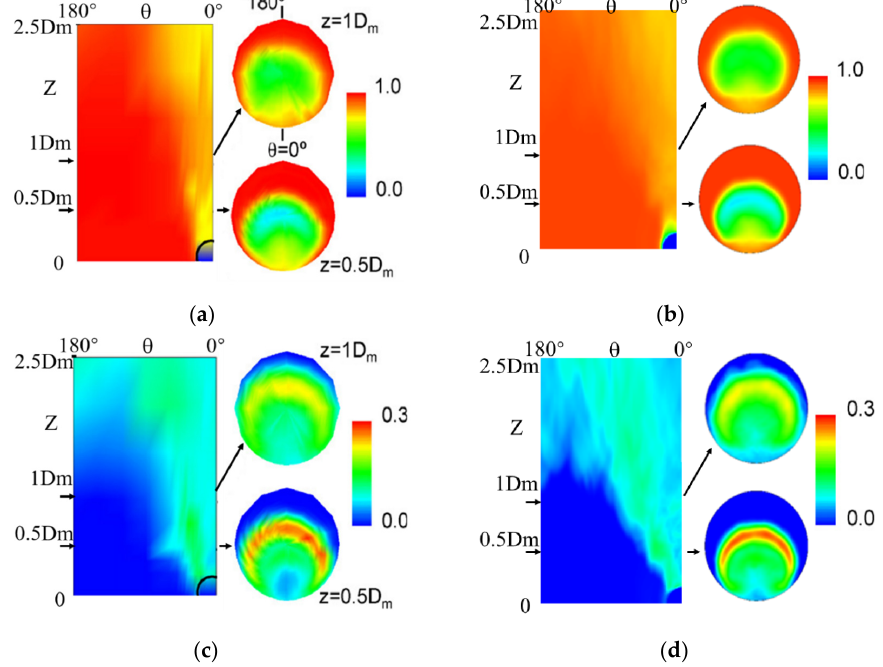
Figure 7. Temperature distribution downstream of D-ref case using LES and ELES: ( a ) Temperature T * distribution using LES; ( b ) Temperature T * distribution using ELES; ( c ) Temperature T sd* distribution using LES; ( d ) Temperature T sd* distribution using ELES.